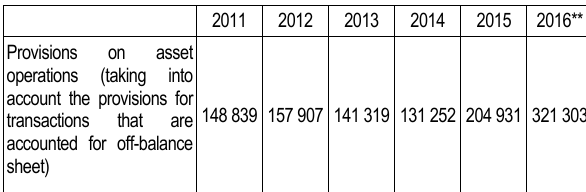
Table 5. Asset operations provisions of the Ukrai- nian banks in the period of